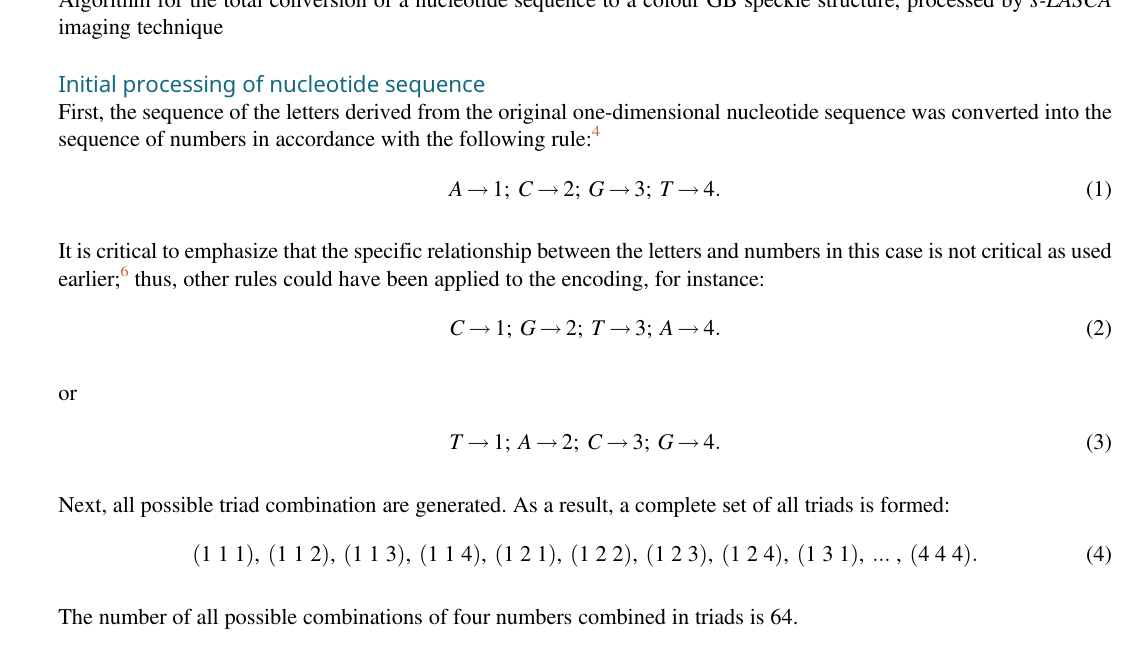
imaging technique Initial processing of nucleotide